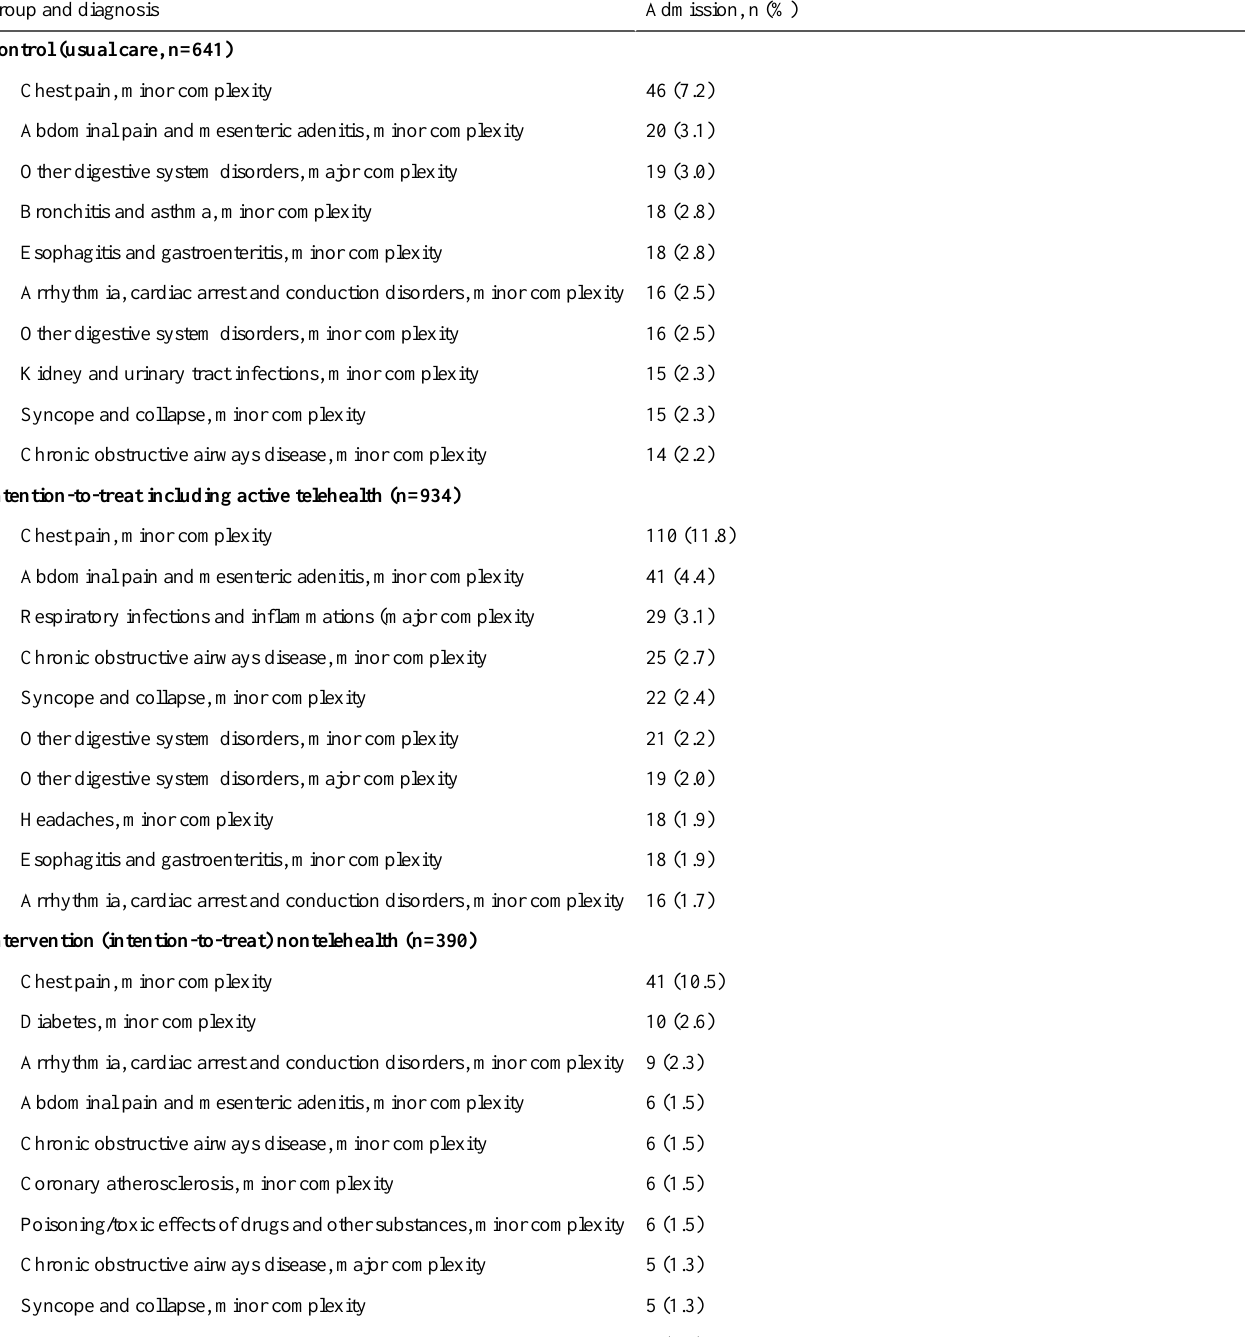
Admission, n (%)Group and diagnosis